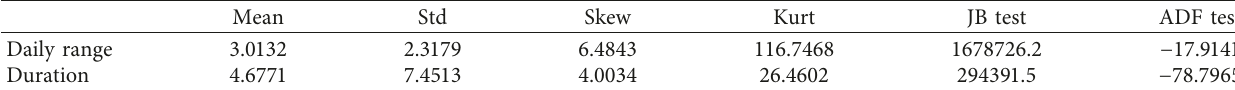
Table 3: Descriptive statistics.